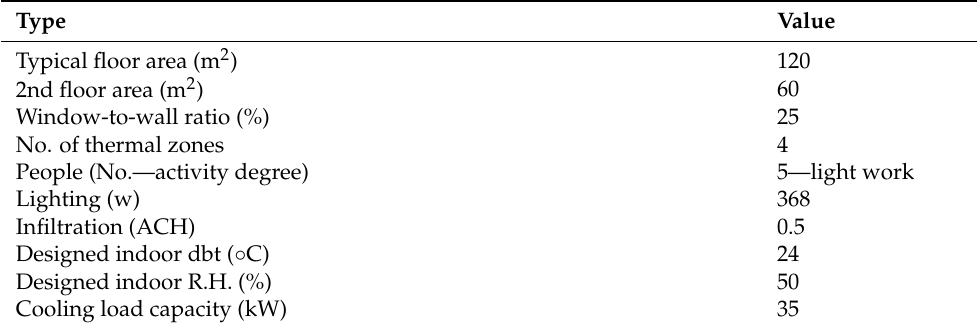
Table 2. Building loads and properties.